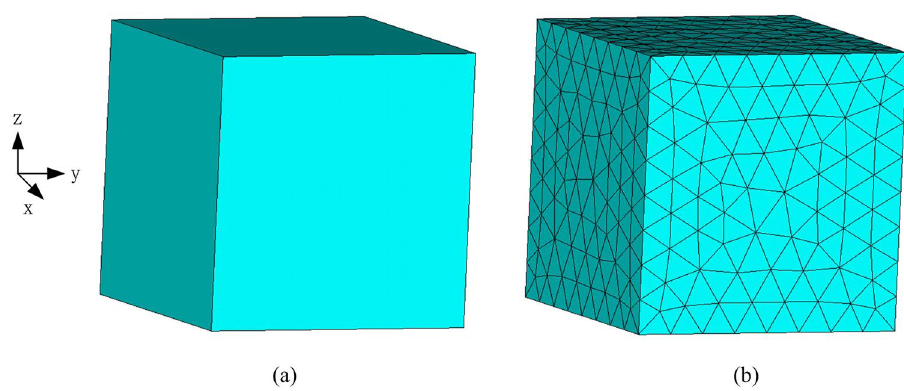
Figure 4. ( a ) Silicon cube model, ( b ) Meshed model with tetrahedral